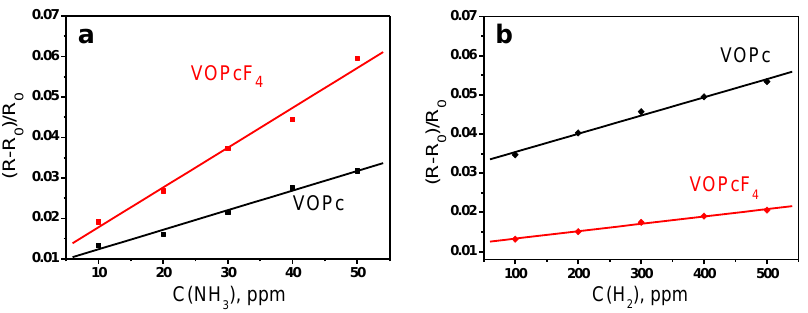
Figure 5. Dependence of the sensor response on ammonia ( a ) and hydrogen ( b ) concentrations for VOPc, VOPcF 4 films.